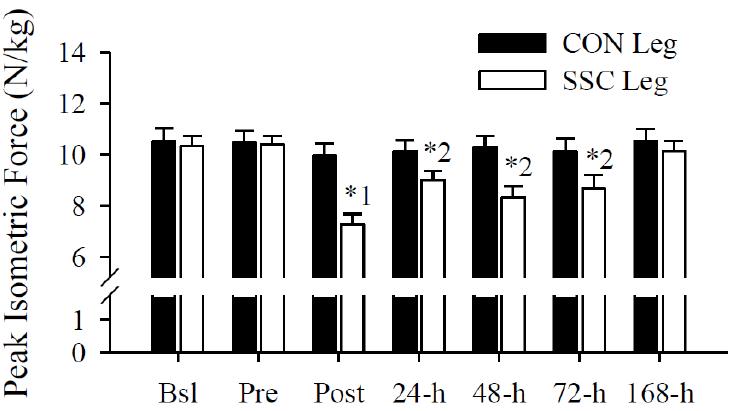
Figure 4. Peak isometric force (N/kg). Single leg peak isometric forces were significantly (leg, time interaction, p < 0.05) different following the SSC protocol. Single-leg peak isometric forces were not significantly different within the control (CON) leg across time, but within the SSC leg, decreased immediately ( 1 p < 0.05 vs. Bsl, Pre, 24-h, 72-h, and 168-h) and remained impaired several days ( 2 p < 0.05 vs. Bsl, Pre, and 168-h) after the intense exercise protocol. Peak isometric forces were also significantly (* p <